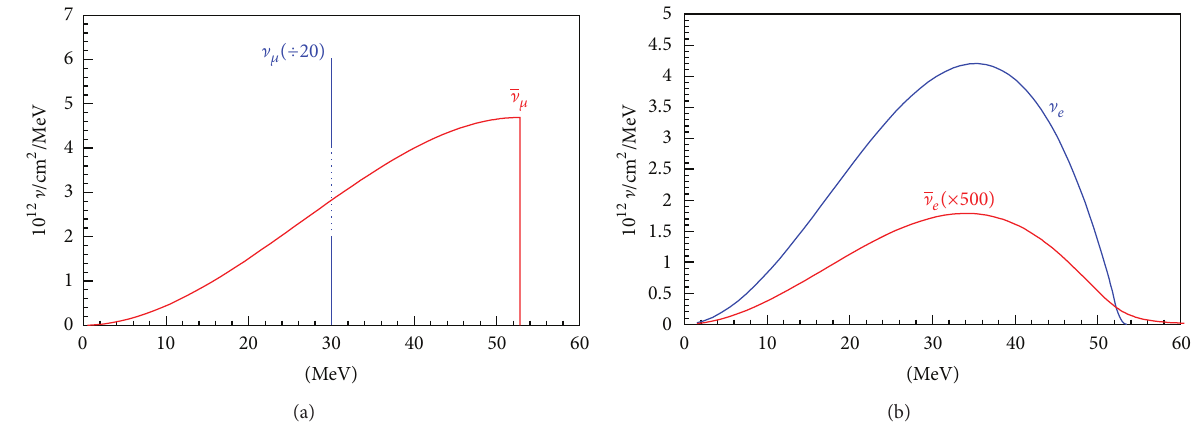
Figure 2: The neutrino energy spectra from 𝜋 + and 𝜇 + DAR.